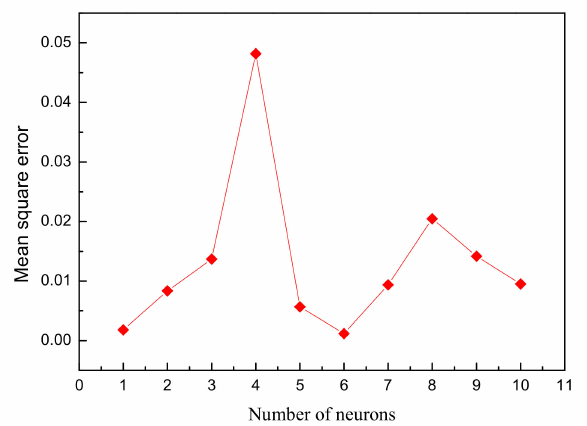
Figure 13. Mean square error (MSE) of neurons in the BP-ANN